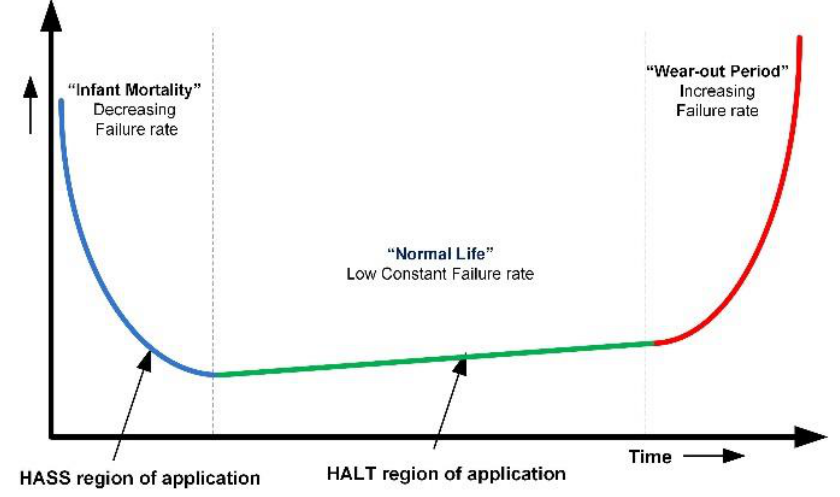
Figure 1. Bathtub curve for electronic products.